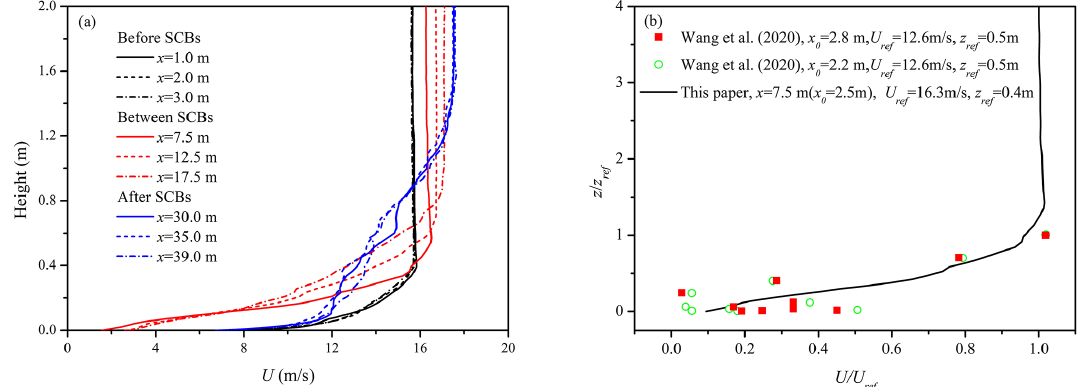
Figure 6. (a) The wind speed profiles of different streamwise positions in the clean airflow containing the SCBs ( u τ = 0 . 6ms − 1 ; N = 5– 20m). (b) The dimensionless wind speed varying with dimensionless height shown as a comparison between our simulated results and the existing experiment.